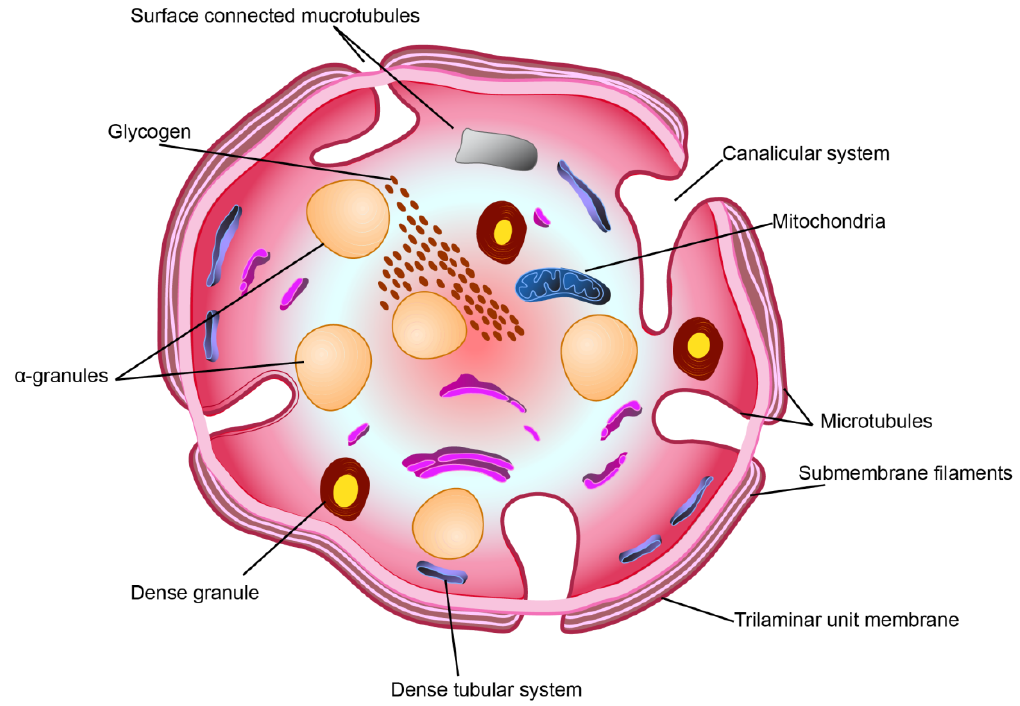
Figure 2. Schematic overview of PLT structure (diagrammatic representation) in the equatorial plane.